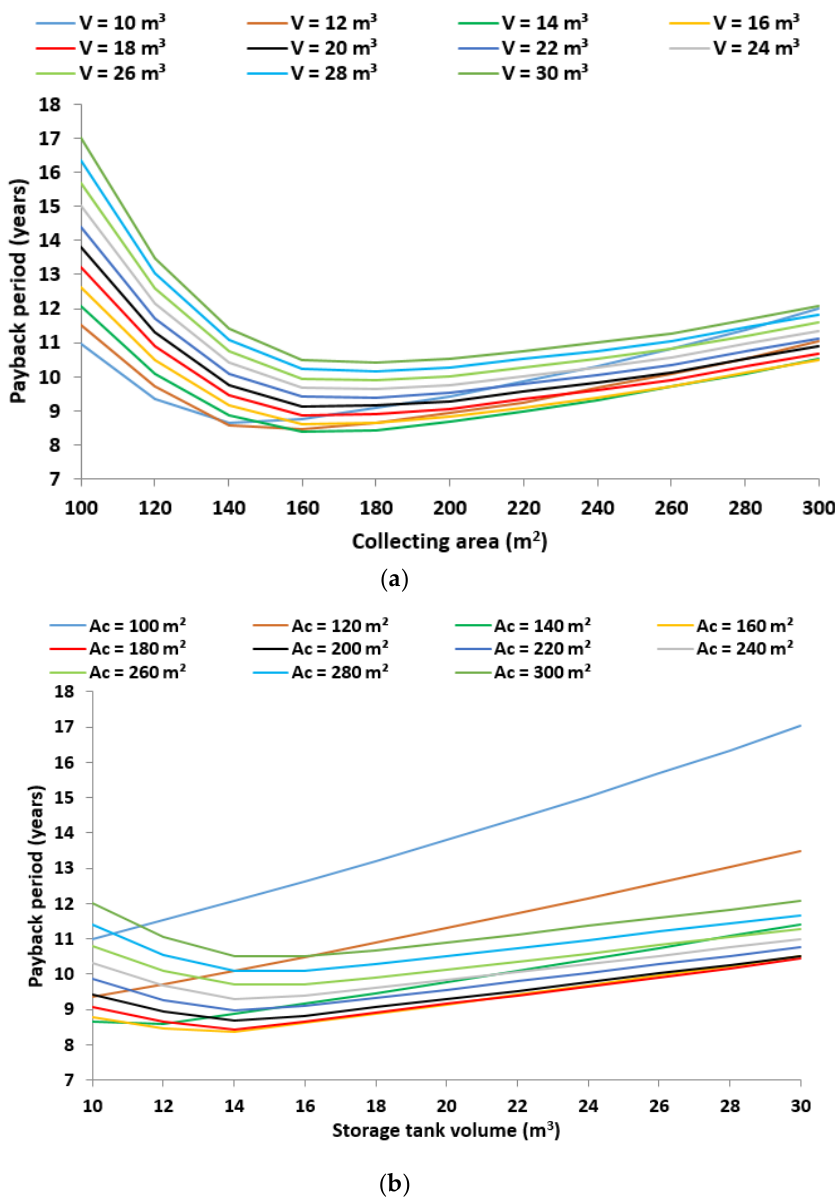
Figure 6. Payback period ( a ) for different collecting areas with the storage tank volume as the main parameter ( b ) for different storage tank volumes with the collecting area as the main parameter.